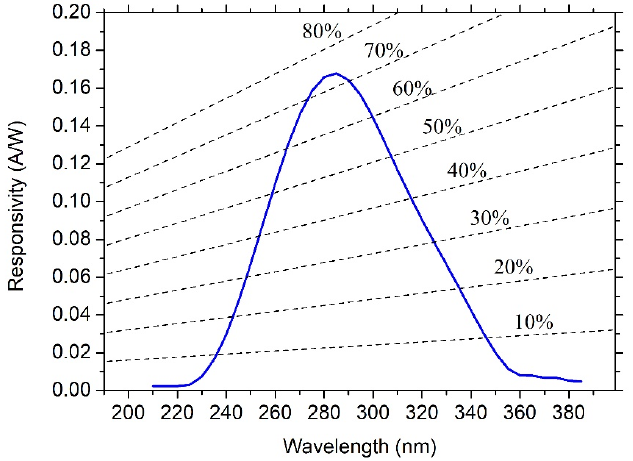
Figure 6 . Responsivity and quantum efficiency (%) of the 4H-SiC photodiode as a function of wavelength.